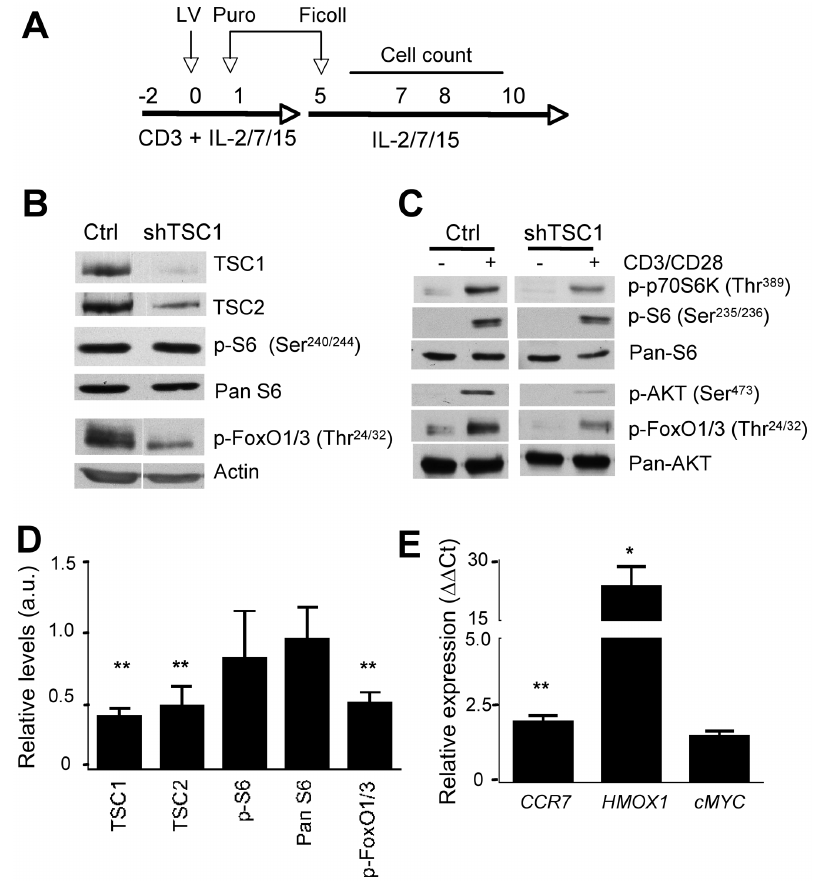
Figure 4. shRNA-assisted TSC1 knock down hinders mTORC2 dependent regulation of FoxO1/3. Human PBMC from 10 independent healthy subjects were activated with anti-CD3 mAb in the presence of IL-2, IL-7 and IL-15 for 48 hours, and transduced with lentiviral vectors overnight (shTSC1). A day after cells were selected for additional 4 days in Puromycin. By then, no viable cells could be recovered from untransduced Puromycin-treated cells. Viable cells in Ctrl and shTSC1 cultures were separated on a Ficoll gradient, counted and re-plated in fresh complete medium supplied with IL-2, IL-7 and IL-15. A) Schematic representation of T cell transduction/selection. B–E) Following viable cell selection at day 5, cells were analyzed by WB (B–D) and real time PCR (E). In B, D cells were left untreated, while in C they were left untreated (-) or stimulated ( + ) in the presence of anti-CD3 (2 ug/ml) and anti-CD28 (5 ug/ml) coated mAb for 30 min, lysed and analyzed by WB. Representative images (B–C) and quantification (D) of 3-6 independent determinations are depicted. Relative levels ( 6 SEM) refer to expression of given proteins normalized to Actin first, and then to control cells. In E, expression of selected FoxO target genes was normalized to the housekeeping gene ( GAPDH ) and expressed relatively to control cells by the DD Ct method. Results depict 4–5 independent determinations. Statistical significance was evaluated by paired, two-tailed Student